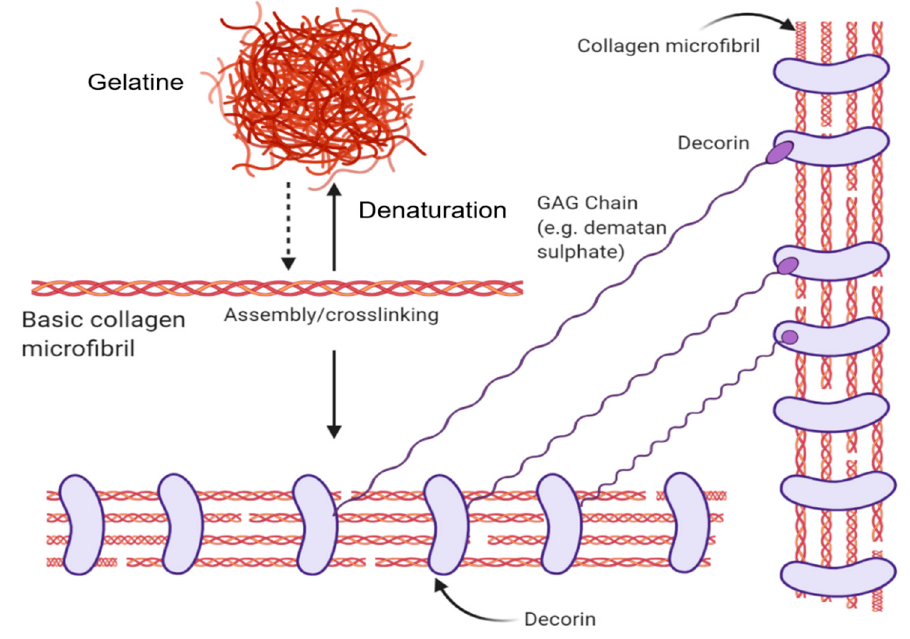
Figure 1. The structural forms of collagen and their native interactions. The basic collagen unit is a triple-helix microfiber that denatures into gelatine or can be assembled into collagen fibrils. Decorin proteins wrap around collagen fibrils in their native context and bind with glycosaminoglycan chains such as dermatan sulphate. Created with BioRender.com.